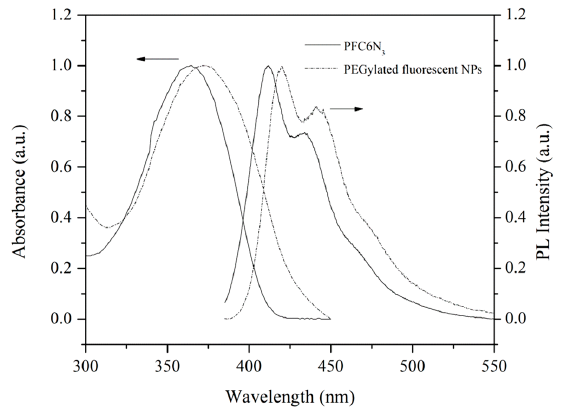
Figure 7. UV–visible absorption and photoluminescence (PL) spectra of PFC6N 3 in THF and the PEGylated fluorescent NPs in water. The excitation wavelength is 370 nm.